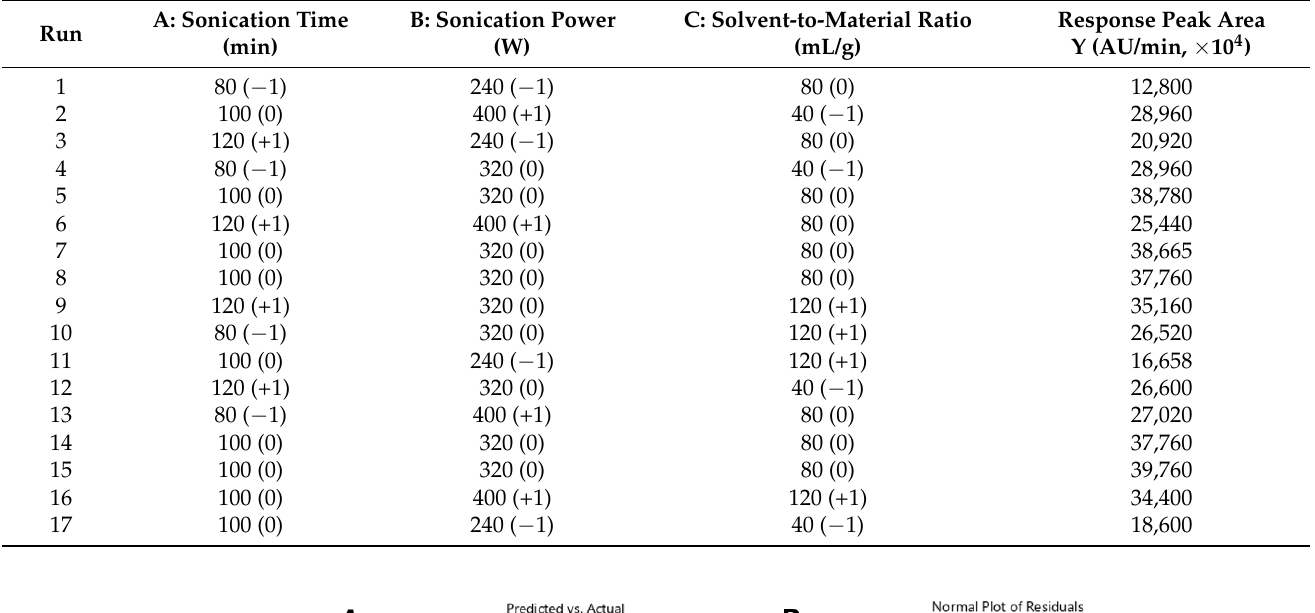
Table 2. BBD matrix for three independent variables in coded form and the peak area in D. crassirhi- zoma ( n = 3).